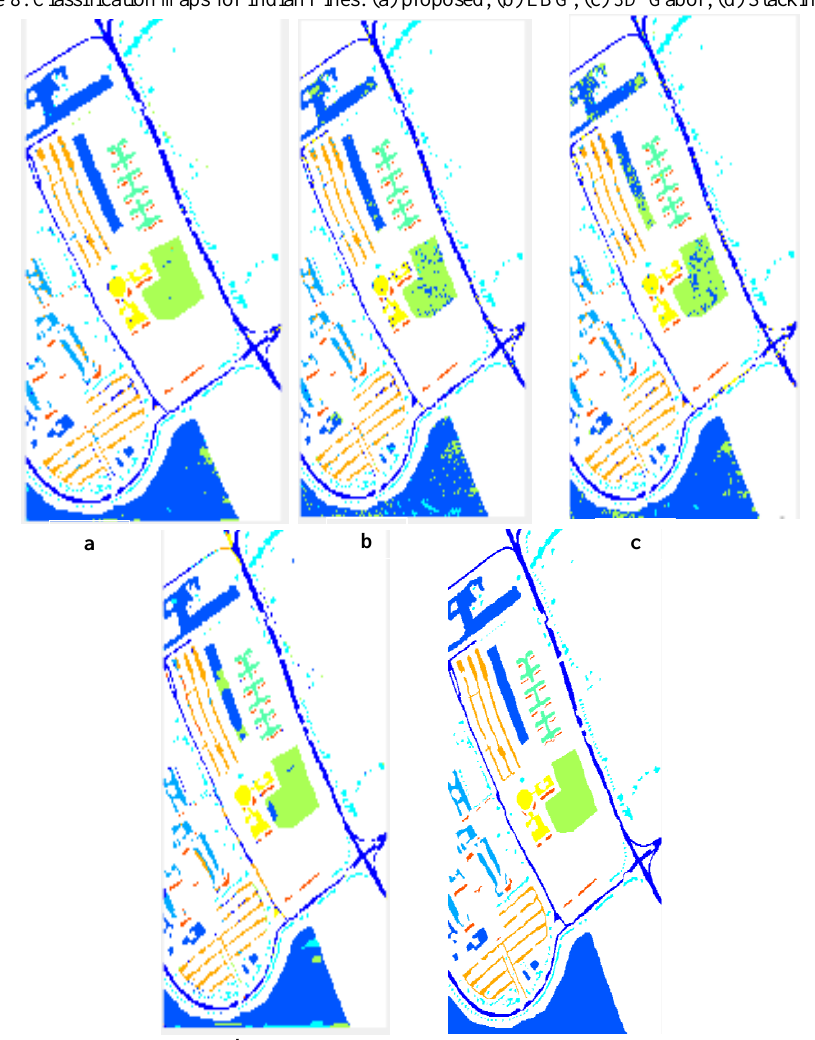
Figure9. Classification maps for Pavia U: (a) proposed, (b) LBG, (c) 3D-Gabor, (d) Stacking and (e)